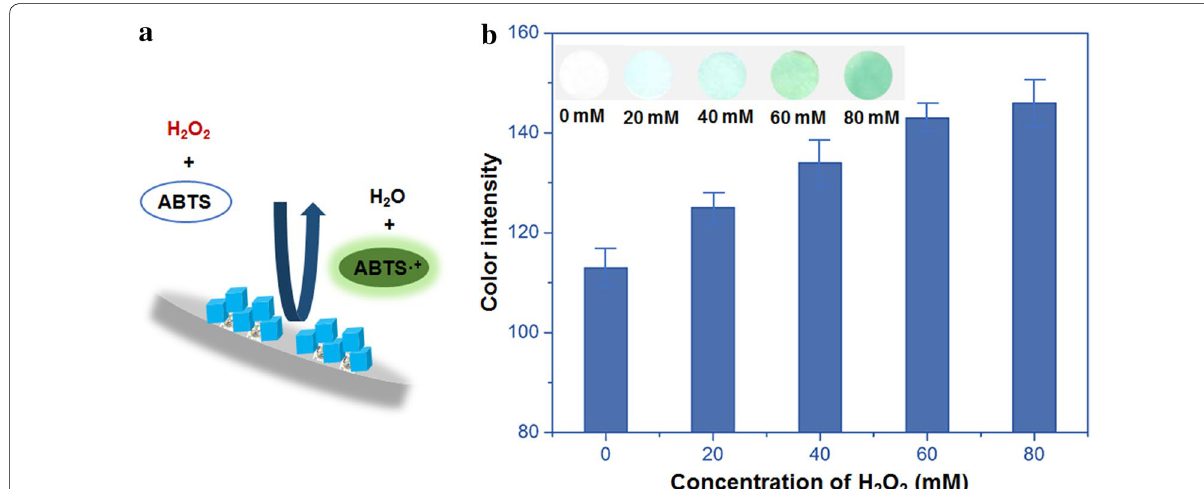
Fig. 3 a Schematic illustration of detection of H 2 O 2 by the Cyt c–ZIF-8 composite testing strip. b Color intensity (gray value) of testing strips devel- oped for different concentrations of